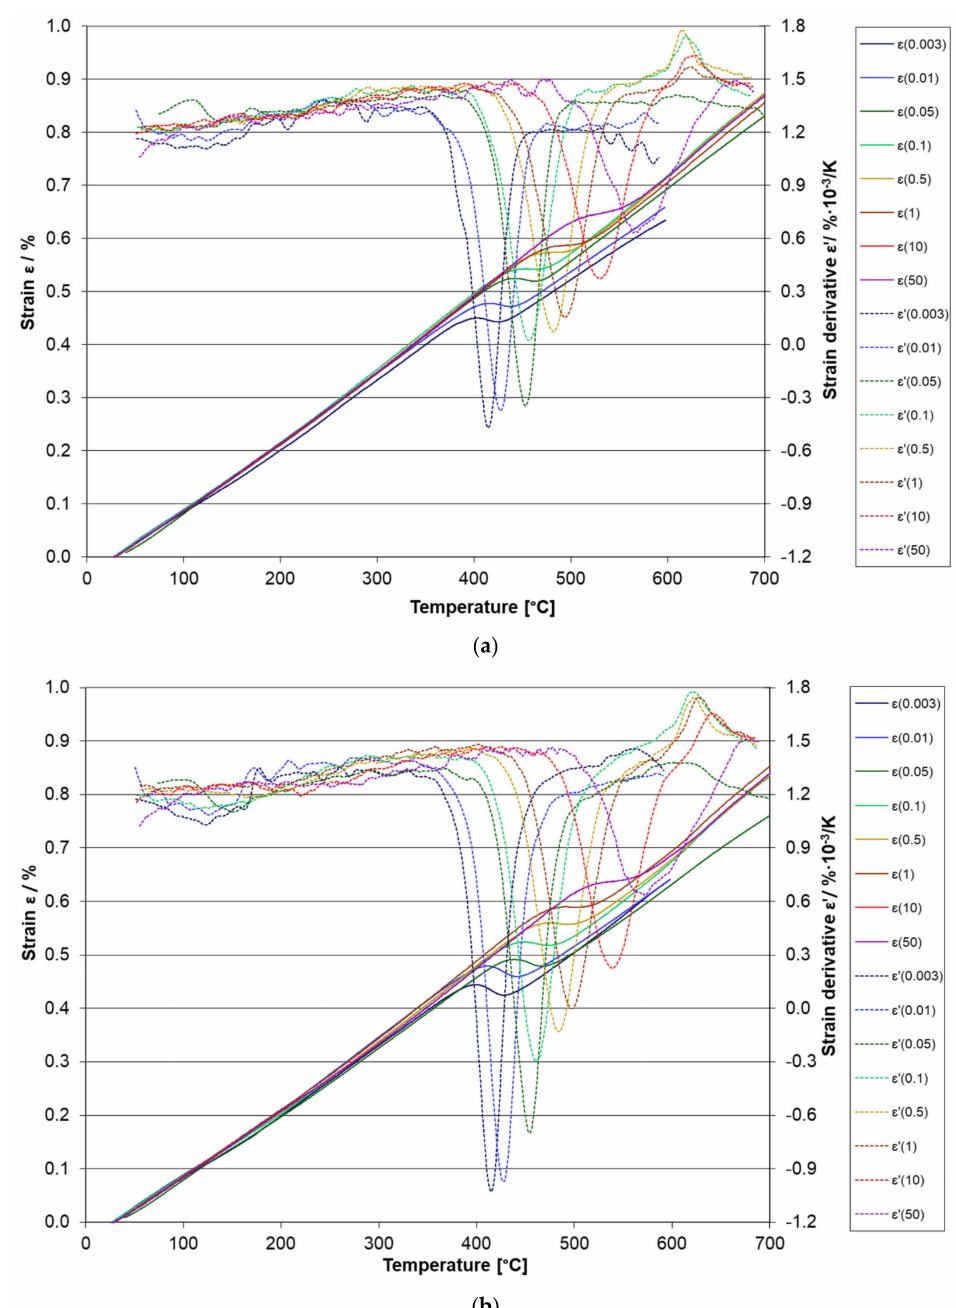
Figure 11. Thermal strain and its derivative for 42SiCr steel ( a ) and 42SiCr + Cu steel ( b ) tempered